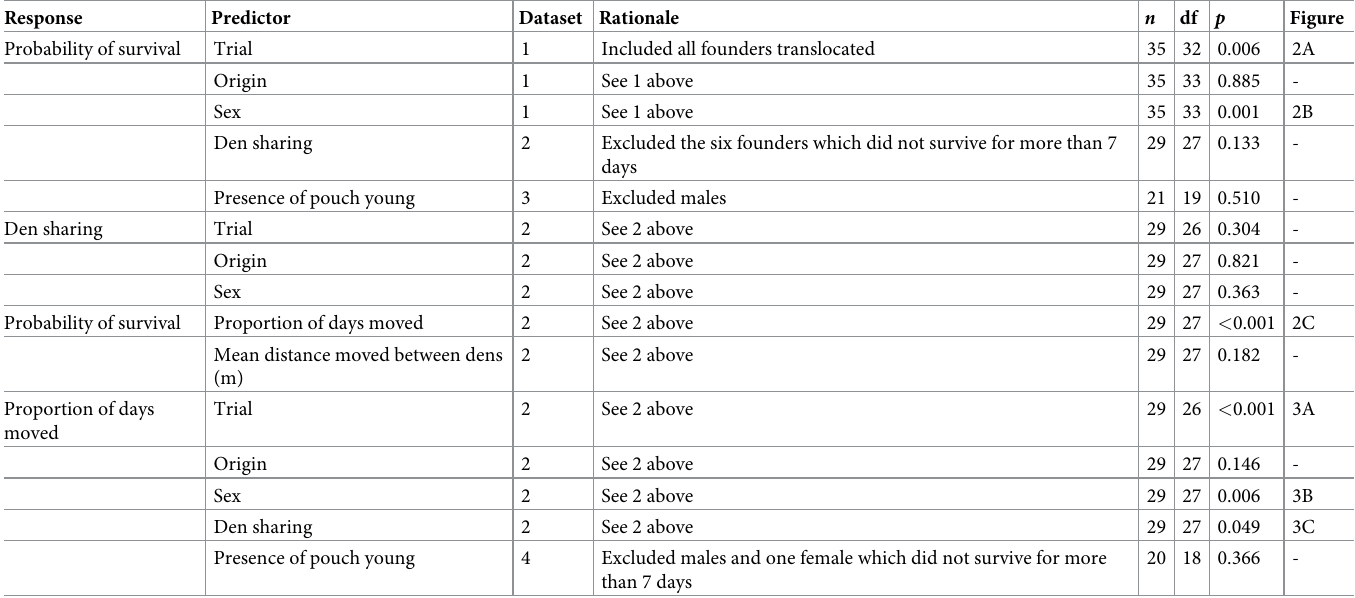
Table 2. Models, datasets used and effect sizes for probability of effective survival, den sharing and proportion of days moved between dens for eastern quolls ( Dasyurus viverrinus ) reintroduced across three trials to Mulligans Flat Woodland Sanctuary, ACT Australia from 2016–18. ‘df’ refers to residual degrees of